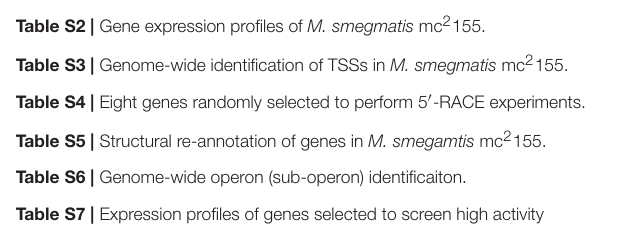
Table S1 | Primers used in this study. Table S2 | Gene expression profiles of M. smegmatis mc 2 155. Table S3 | Genome-wide identification of TSSs in M. smegmatis mc 2 155. Table S4 | Eight genes randomly selected to perform 5 ′ -RACE experiments.